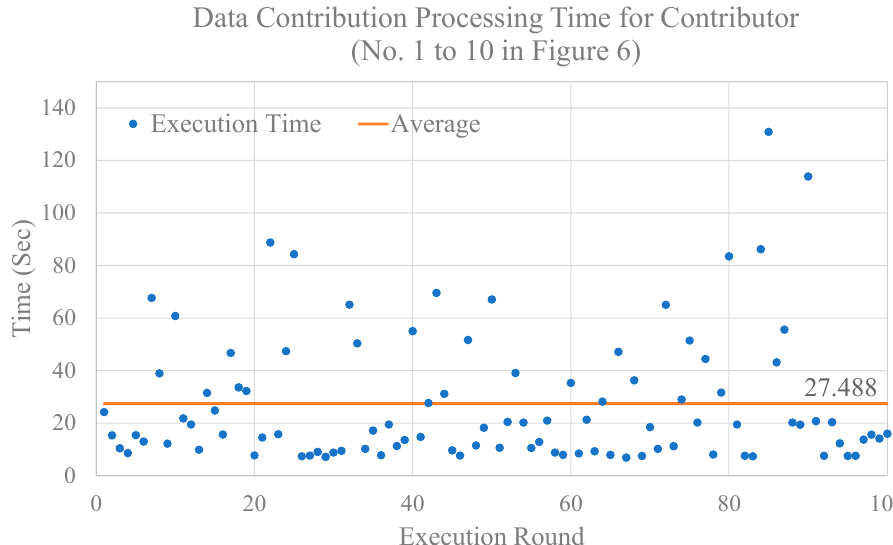
Figure 9. Data contribution processing time in each round for the contributor.